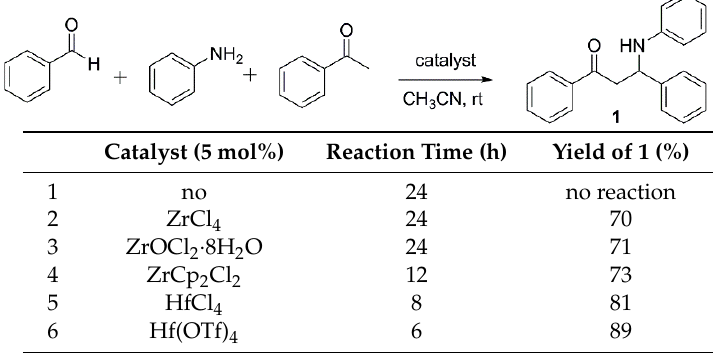
Table 1. The catalytic effect of Group IVB transition metal Lewis acids on Mannich reaction a .